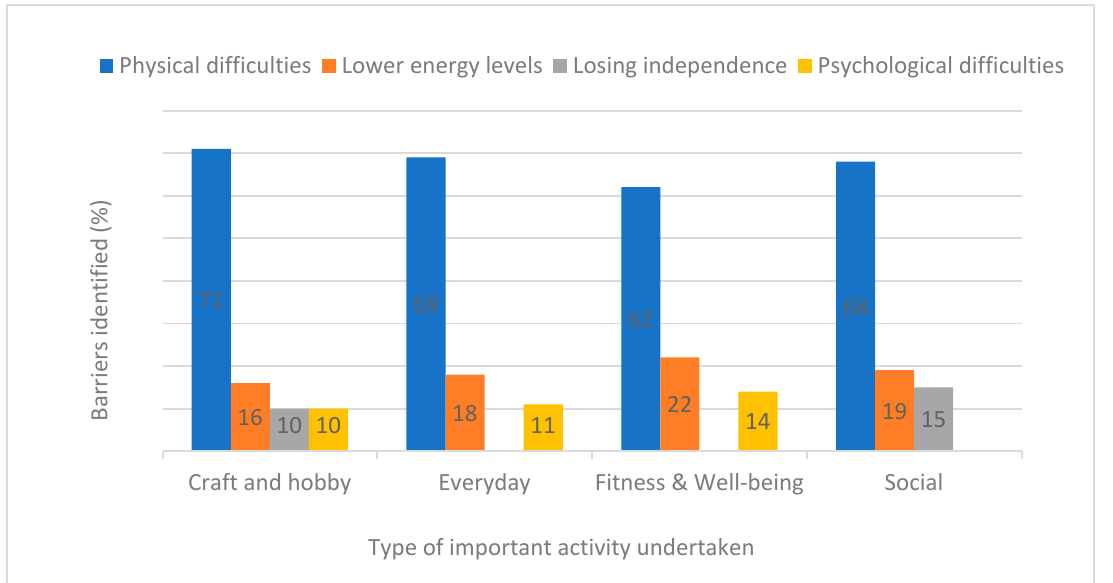
Figure 3. Top three reported barriers to activity(%) at 6 month follow-up by type of important activity undertaken.